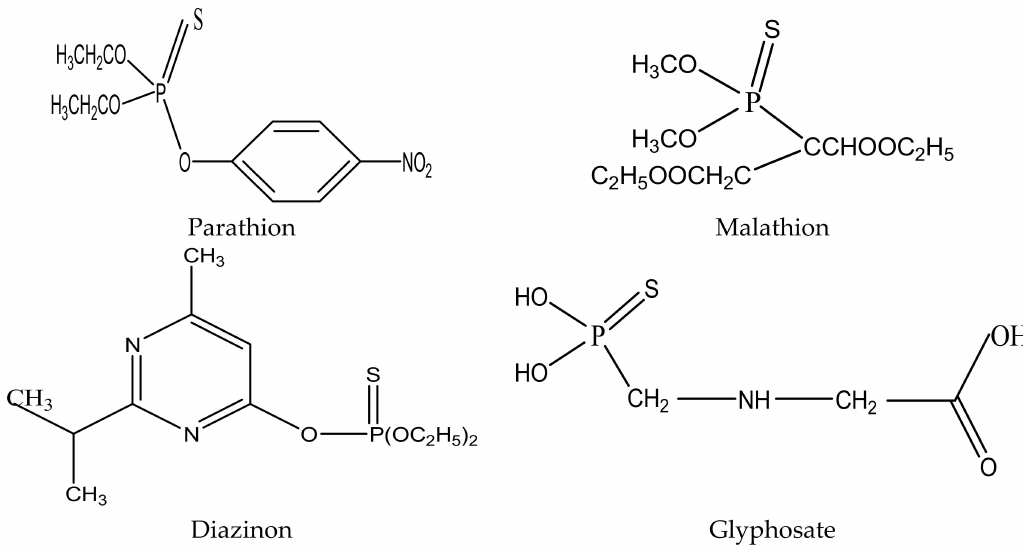
Figure 2. Structures of commonly used organophosphate